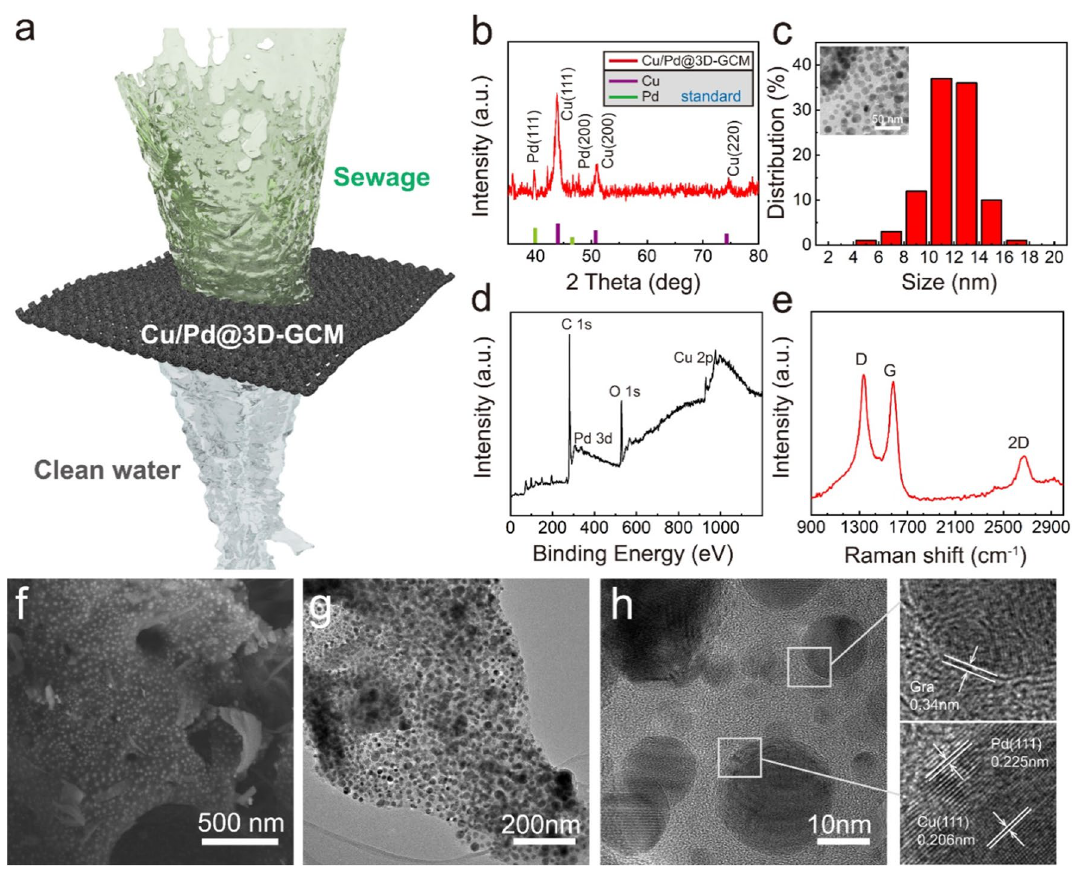
Fig. 1 a Schematic diagram of the sewage treatment in Cu/Pd@3D‑GCM. b XRD patterns, c Size distribution of MNPs, d The XPS spectra of Cu/Pd@3D‑GCM, and e Raman spectra of Cu/Pd@3D‑GCM. f SEM image, g TEM image, and h high‑resolution TEM images of Cu/Pd@3D‑